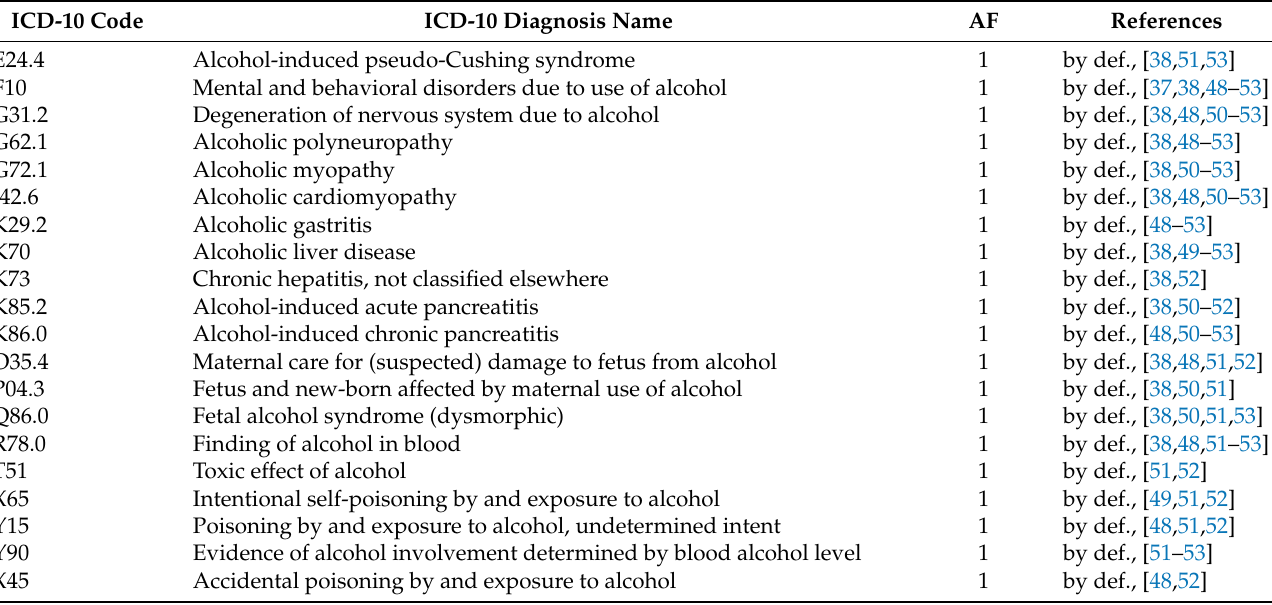
Table 1. Diagnoses wholly attributable to